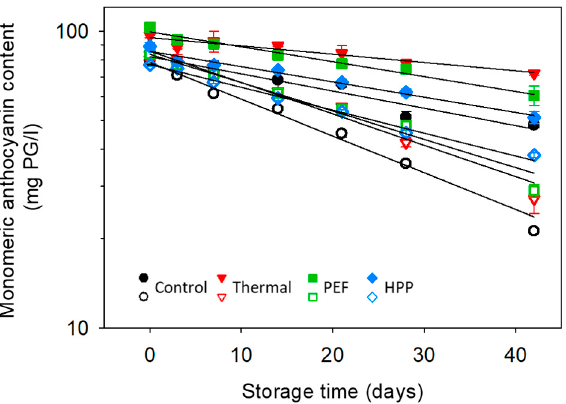
Figure 5 . Kinetic modelling of the monomeric anthocyanin contents (pH differential) during re-